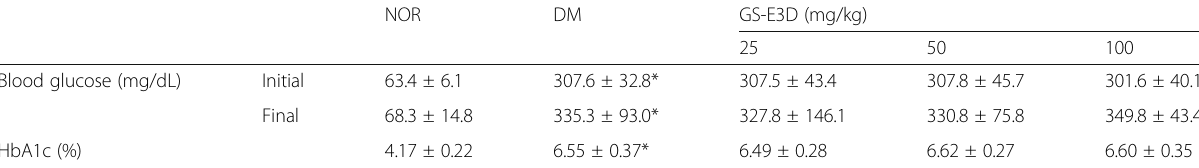
Table 1 Blood glucose and HbA1c